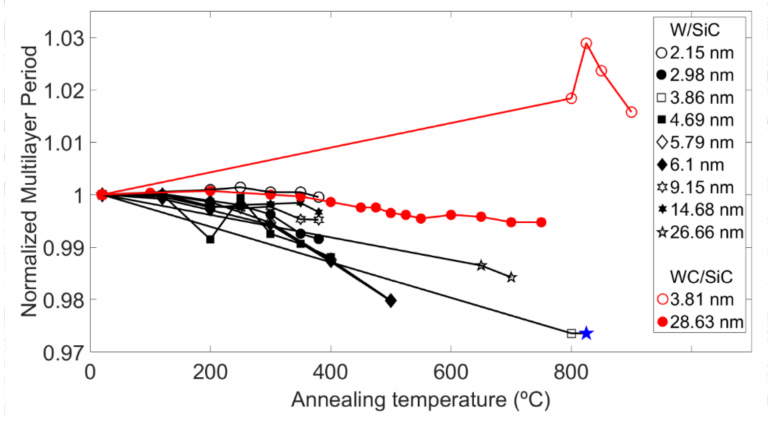
Figure 1. Normalized multilayer period of W/SiC (black) and WC/SiC (red) multilayers as a function of annealing temperature. The blue star indicates the point where the W/SiC multilayer delaminated from the silicon